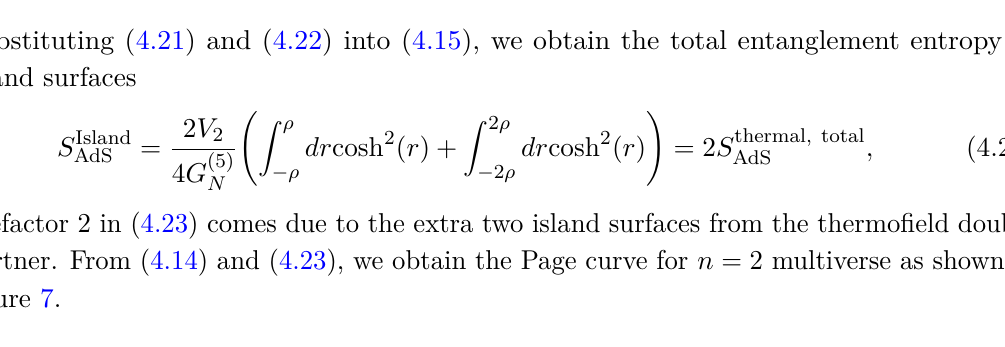
Figure 7 . Page curve of eternal AdS black holes for n = 2